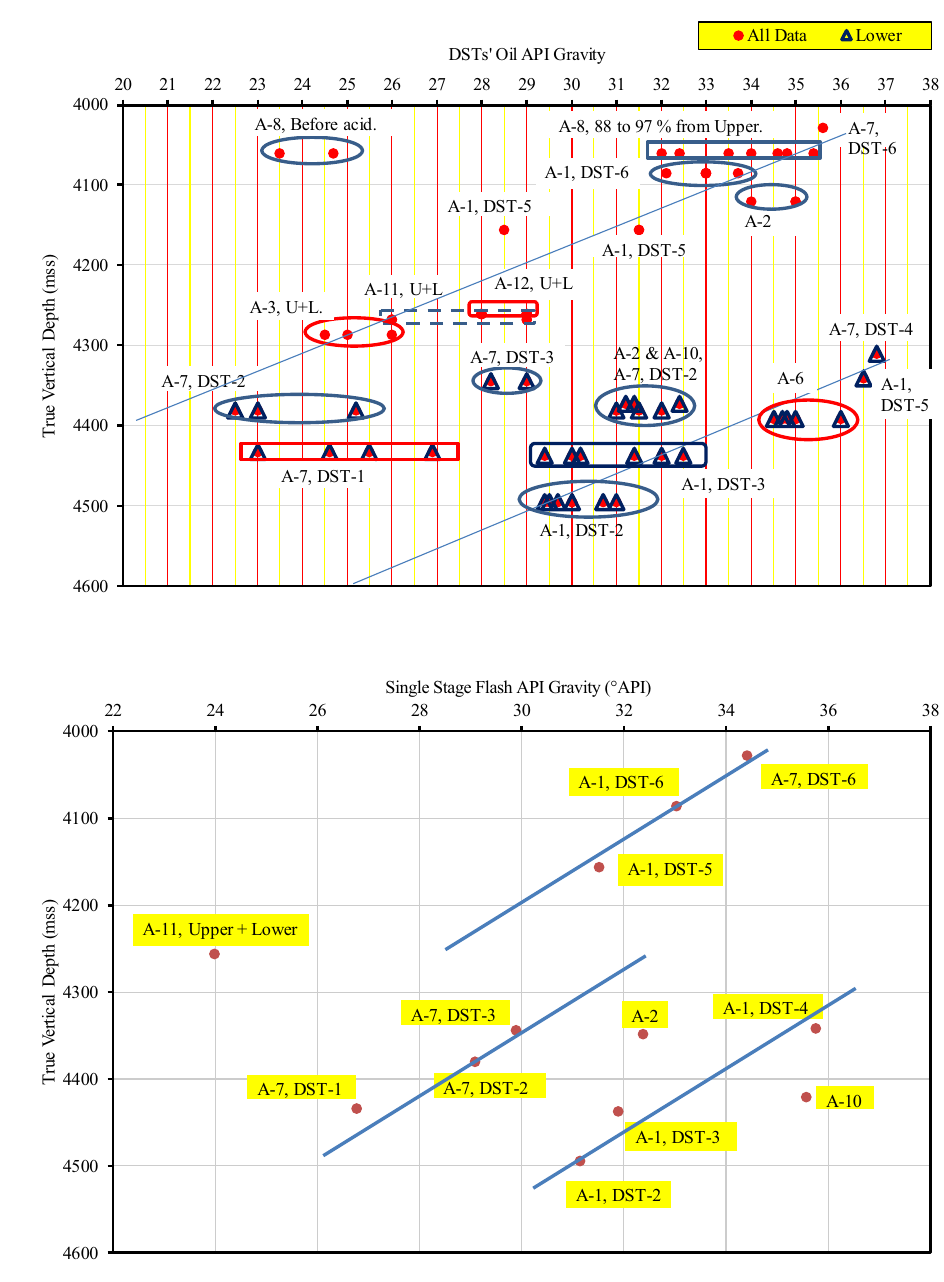
Fig. 3 Measured oil API gravi- ties during FBDSTs